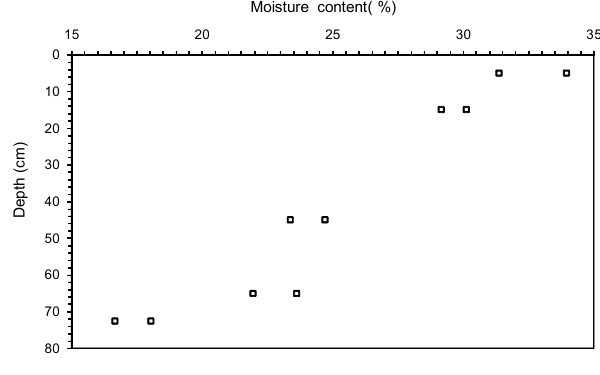
Fig. 2. Relationship between moisture and depth within the proposed trial area at Car Wood